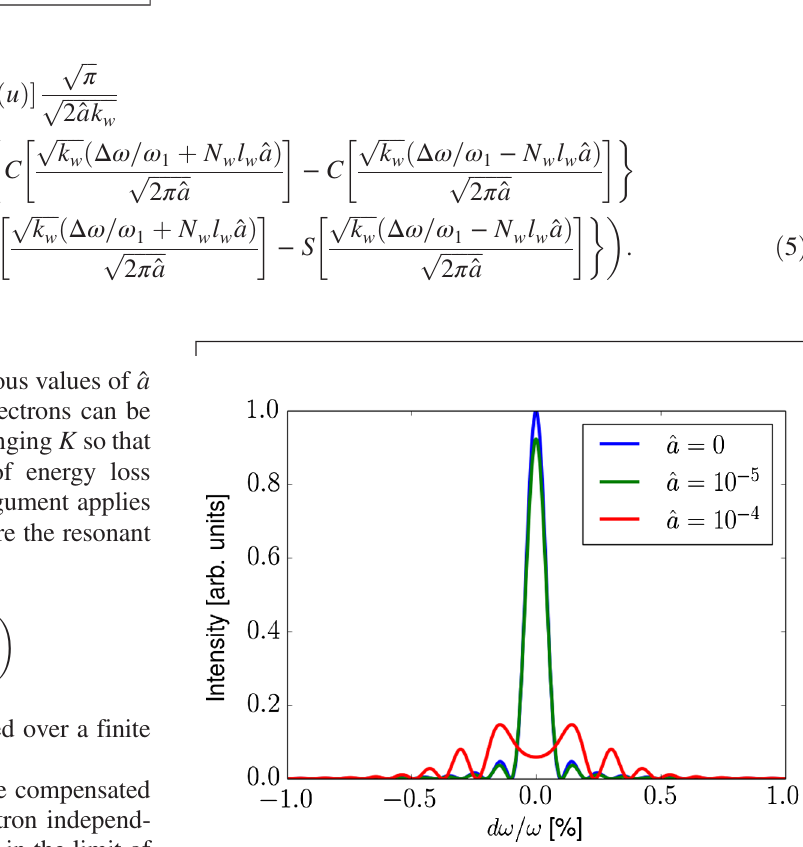
FIG. 4. Spectrum corresponding to various energy drift parameters, N w ¼ 1000